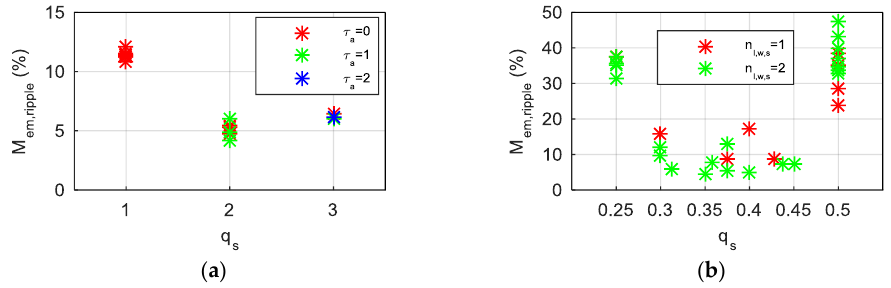
Figure 15. Torque ripple ( M em,ripple ) versus stator slot number per pole and phase ( q s ) ( a ) and short pitching ( τ a ) for ISDW machines; ( b ) and slot layer number ( n l,w,s ) for FSCW machines.